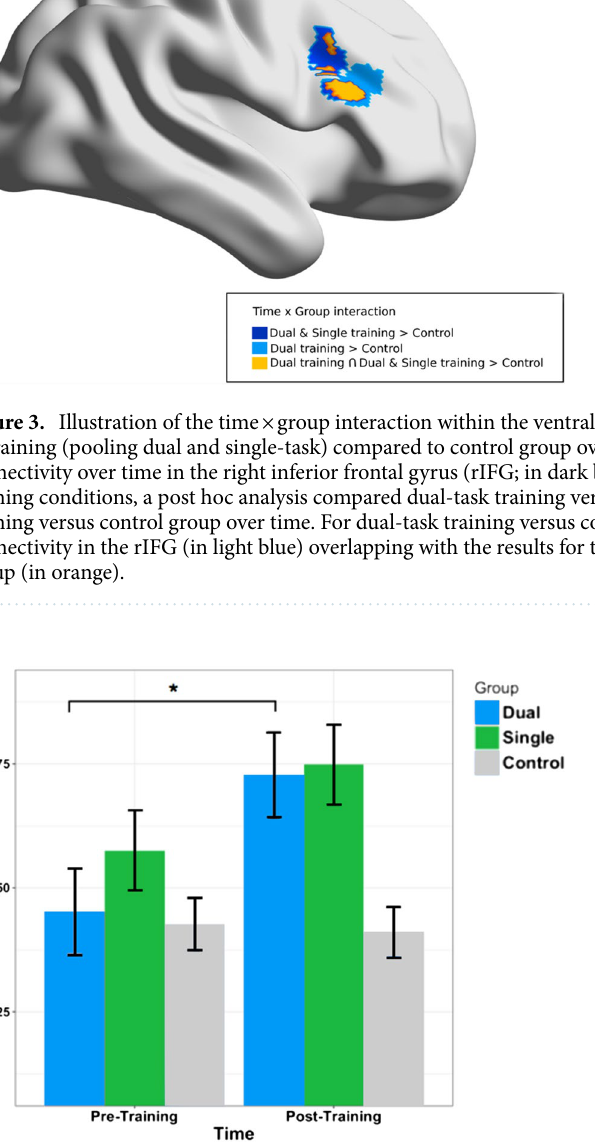
Post hoc analysis dual‑task training versus controls and single‑task training versus controls. To back this up fur- ther in terms of connectivity in the ventral DMN, we performed a post hoc analysis exploring separately the contrast dual-task training versus controls and single-task training versus controls. With a threshold of p < 0.05 (FWE correction for multiple comparison), we found a significant group ×time interaction for the contrast dual- task training vs. control group in the rIFG (58, 24, 26, Fig. 3 in light blue) overlapping with the results of the ini- tial analysis in this network (Fig. 3, in orange, both clusters are within the rIFG and the voxel overlap is 51% (48 voxels out of 94). In the reverse contrast (control > dual-task training, p < 0.05 FWE) we found a significant effect in left superior parietal cortex (− 26, − 56, 58–k = 97) indicating a decreased connectivity of the dual-task train- ing group over time. We found no significant effects in the contrast single-task training versus control group. In order to test whether the group × time interaction in the connectivity within the ventral DMN was not due to differences already present in the pretest sessions, we contrasted the pre-test of single-task and the pre- test of the dual-task. We did not find statistically significant differences between the pre-tests ( p > 0.05 FWE on cluster level).